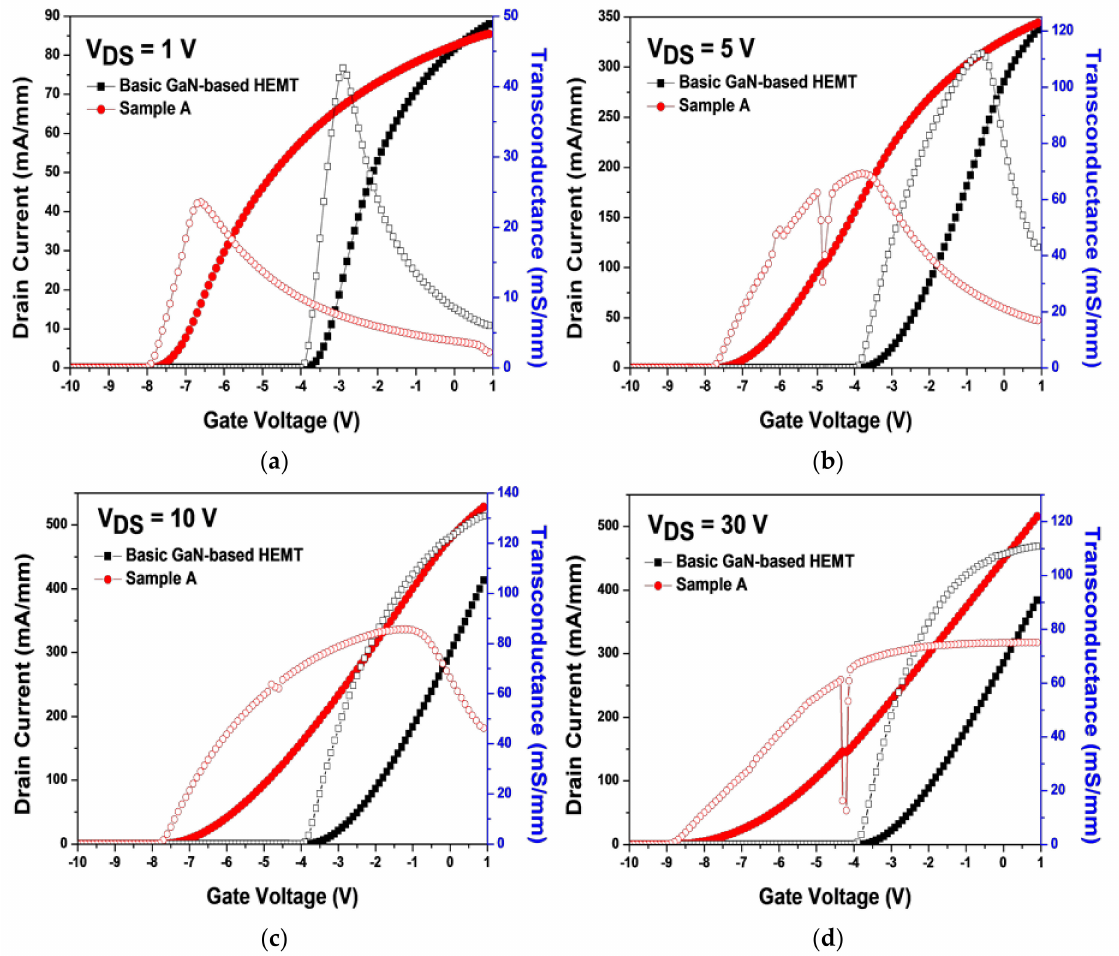
Figure 5. Transfer I–V characteristics for BG-HEMT and MIS-HEMT (sample A) at ( a ) V DS = 1 V, ( b ) V DS = 5 V, ( c ) V DS = 10 V, and ( d ) V DS = 30 V (drain current (filled dot), transconductance (empty